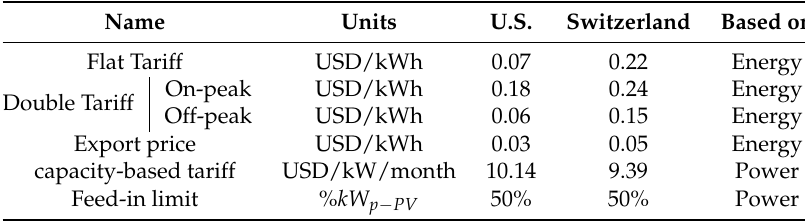
Table 3. Electricity tariff components depending on the bill structure used in this study. The peak time in Geneva occurs from 7:00 to 22:00 on weekdays and from 17:00 to 22:00 for the weekends, whereas it is from 13:00 to 19:00 for the weekends between June and September in Austin. The PV export price corresponds to the wholesale price, with the given value corresponding to the average wholesale